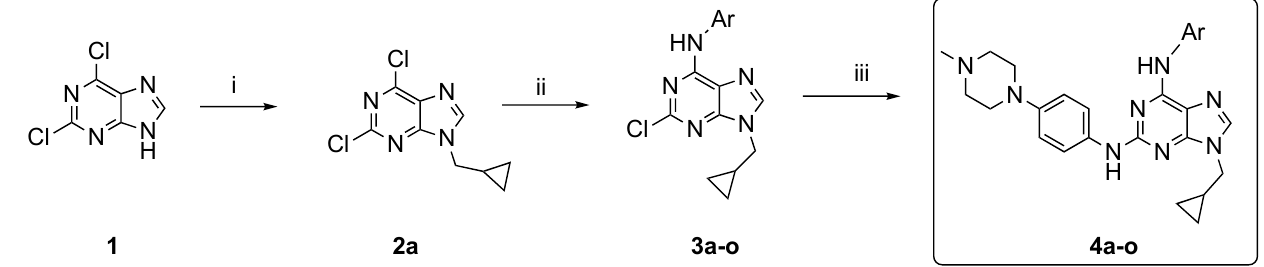
Table 1. In vitro inhibition of compounds 4a – o , 5a – l , 8a – c and 12 of the kinases Abl, BTK, FLT3-ITD and Cdk-2/Cyclin